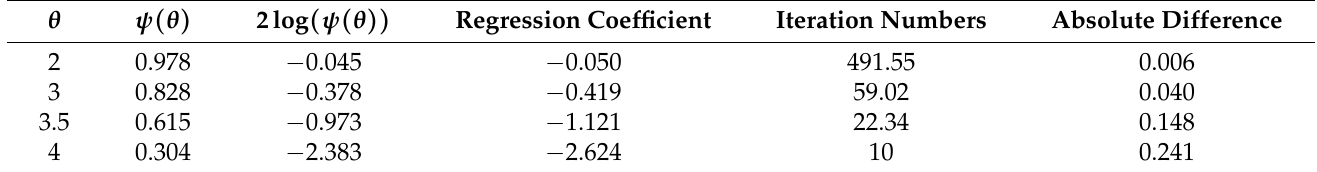
Table 1. The simulation results when the sample size is fixed. The last column show the absolute differ- ence between the third column and the fourth column, given by | 2log ( ψ ( θ )) − Regression coefficient | .